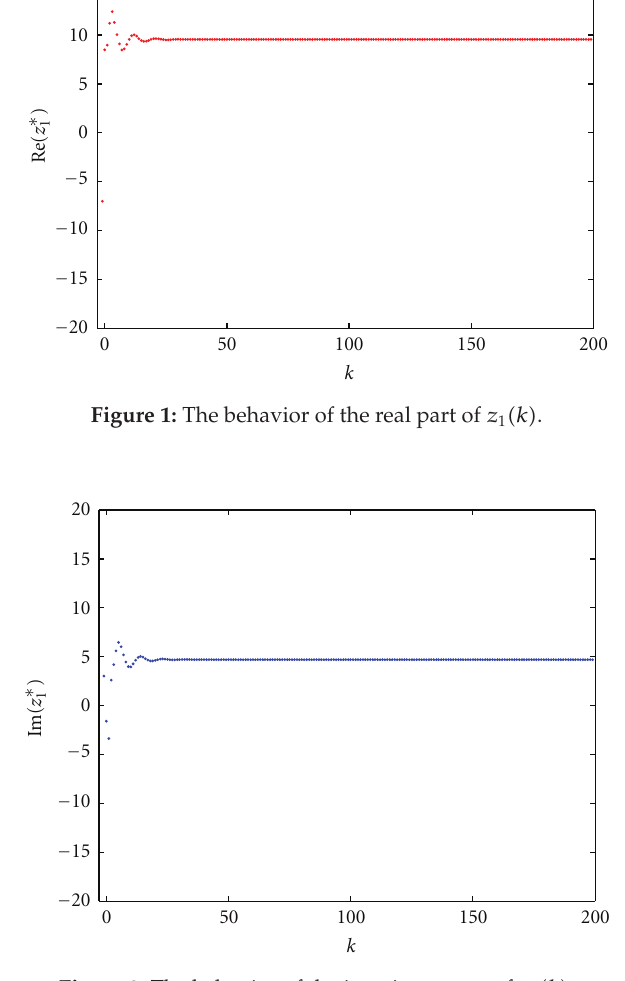
Figure 2: The behavior of the imaginary part of z 1 (cid:5) k (cid:7)